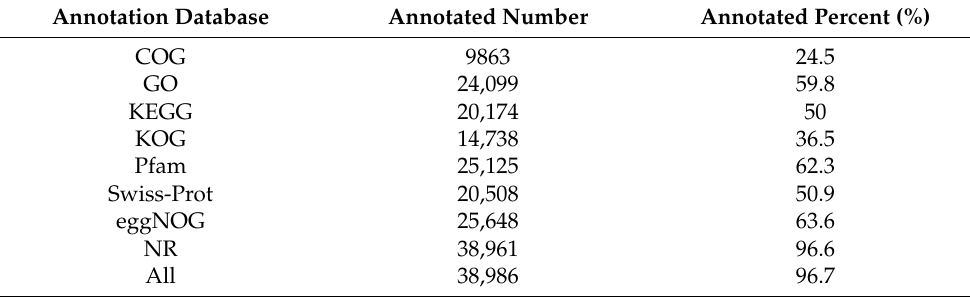
Table 3. Summary table of gene function annotations.